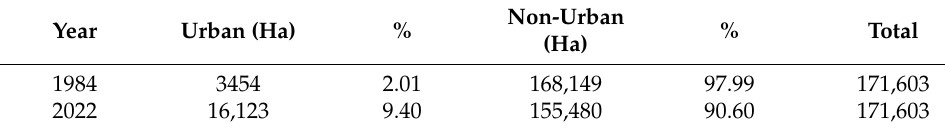
Table 5. Landsat classification results values.